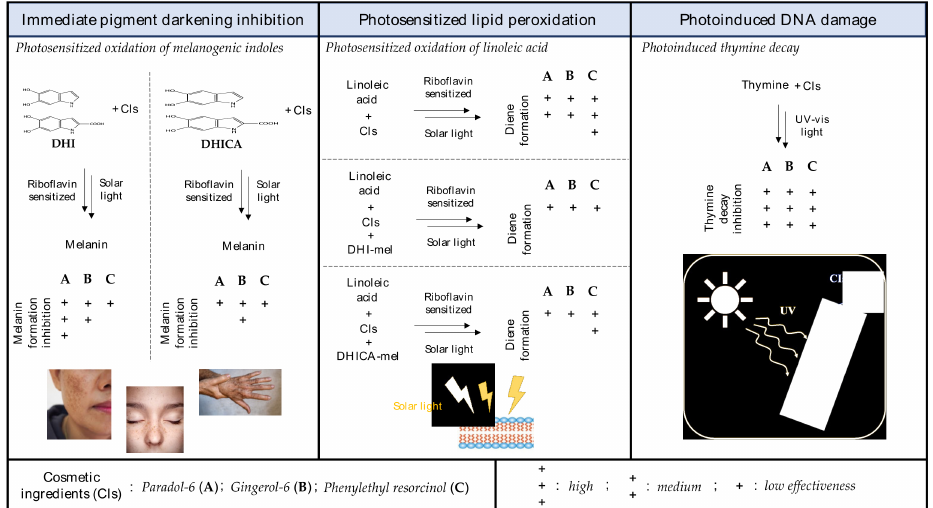
Figure 11. Summarizing scheme of the main outcomes of the study.